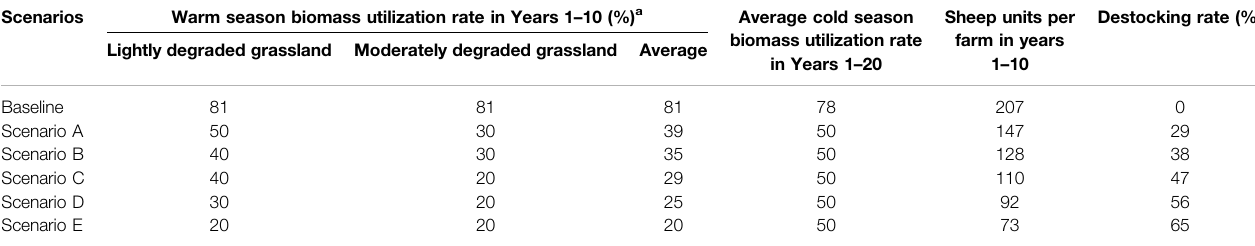
TABLE 1 | Biomass utilization rates, herd size and destocking rates in the baseline and fi ve with-project scenarios modeled.